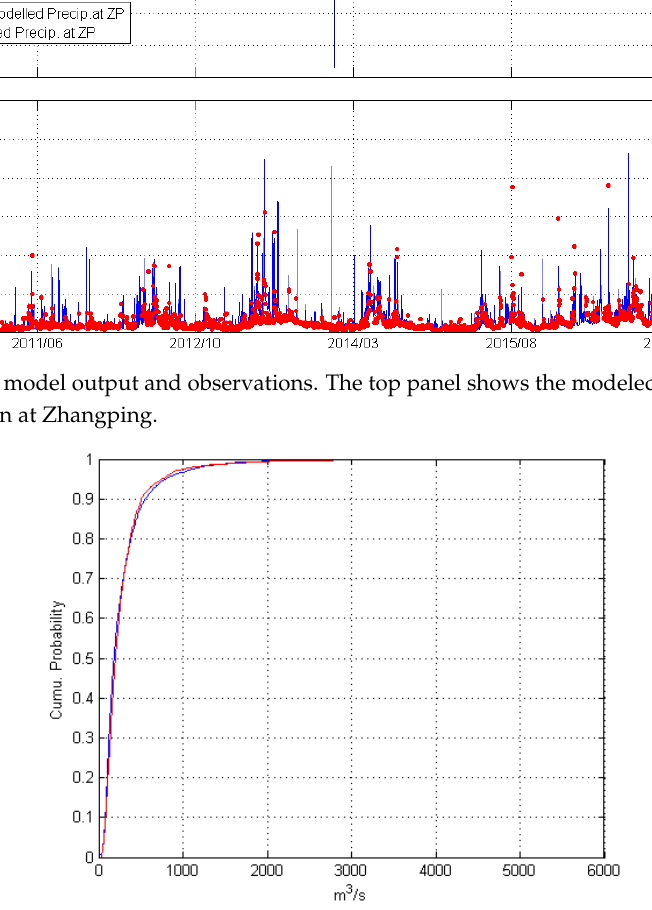
Figure 11. Cumulative distribution of daily 08:00 flow rate of simulation and observation. Table 12. HSPF model skill for monthly average runoff.